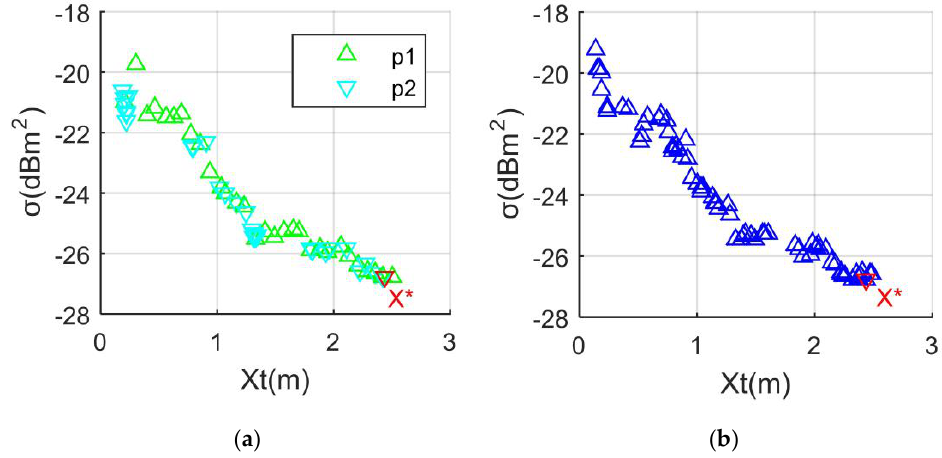
Figure 2. Verification of the search algorithm. α m = 60 ° , F rh = 6 GHz, β = 0 ° : ( a ) TPS results; ( b ) SA results.